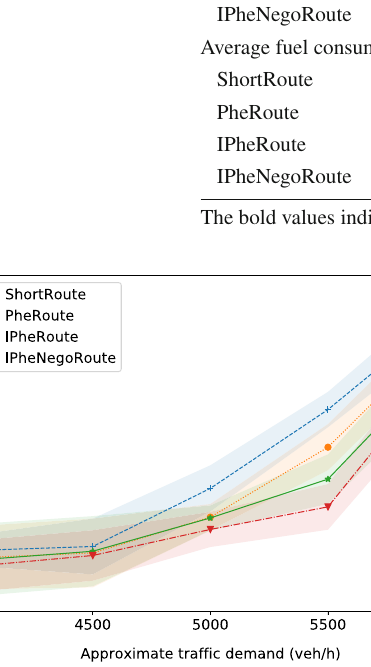
Fig. 9 Performance of the IPheNegoRoute method under different compliance rates